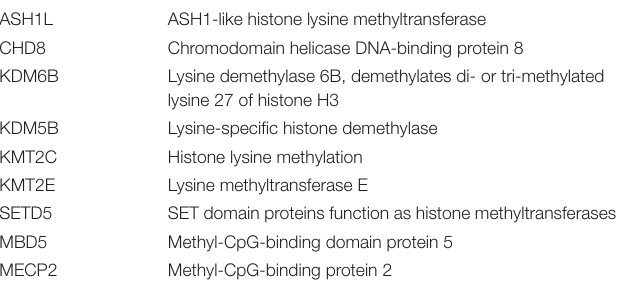
TABLE 2 | Epigenetic and chromatin factors with defects in specific cases of autism spectrum disorders (Satterstrom et al., 2020). ASH1L